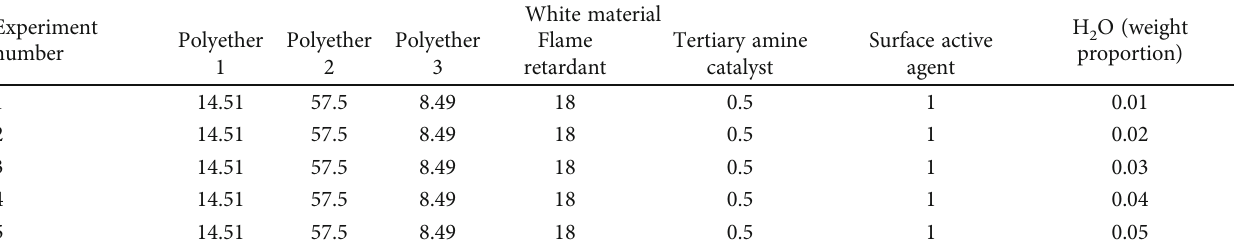
Table 1: Experiment weight proportion scheme of water (%).